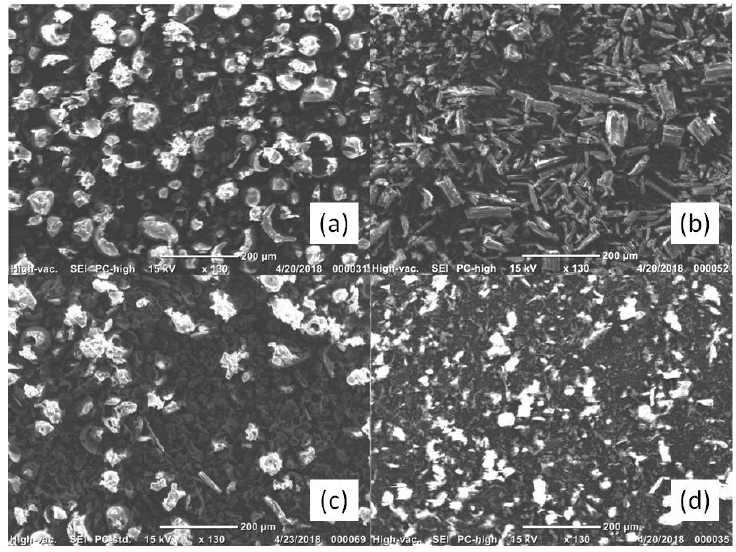
Figure 2. Scanning electron microscope (SEM) images of 2-hydroxypropyl- β -cyclodextrin (HP- β -CD) ( a ), idebenone (IDE) ( b ), IDE + HP- β -CD physical mixture ( c ), and IDE/HP- β -CD inclusion complex ( d ).